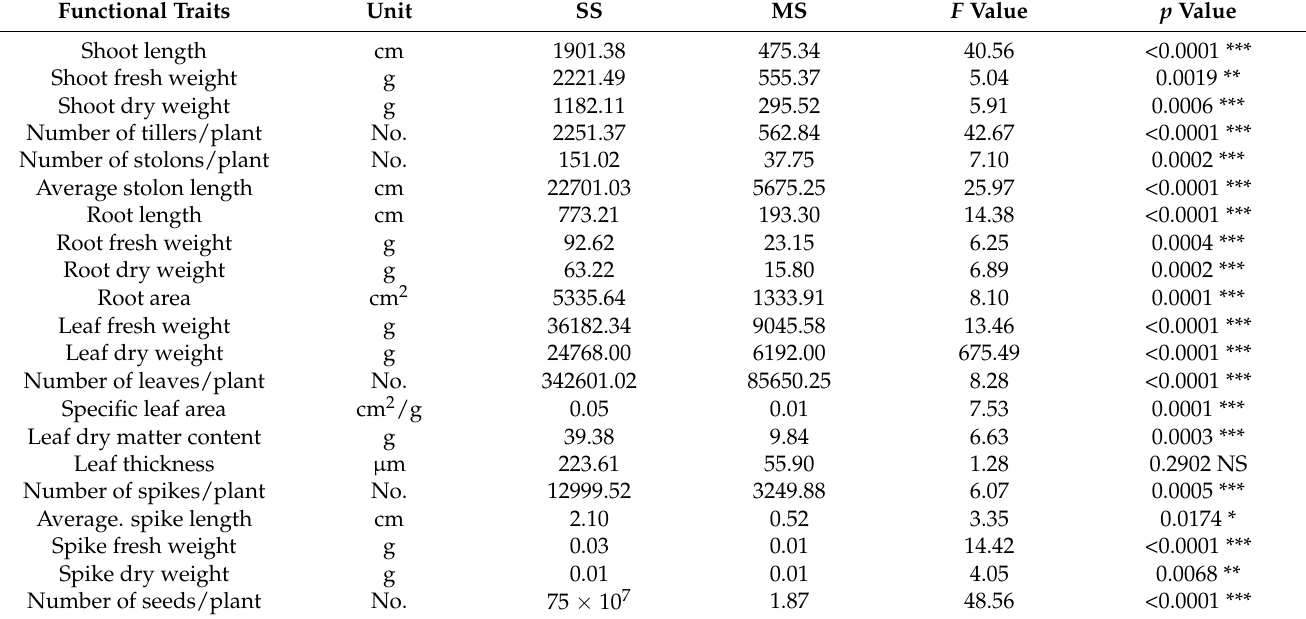
Table 2. Single-factor analysis of variance (ANOVA) showing the effect of different saline regions on plant functional traits and biomass allocation of A. lagopoides having a degree of freedom of the studied